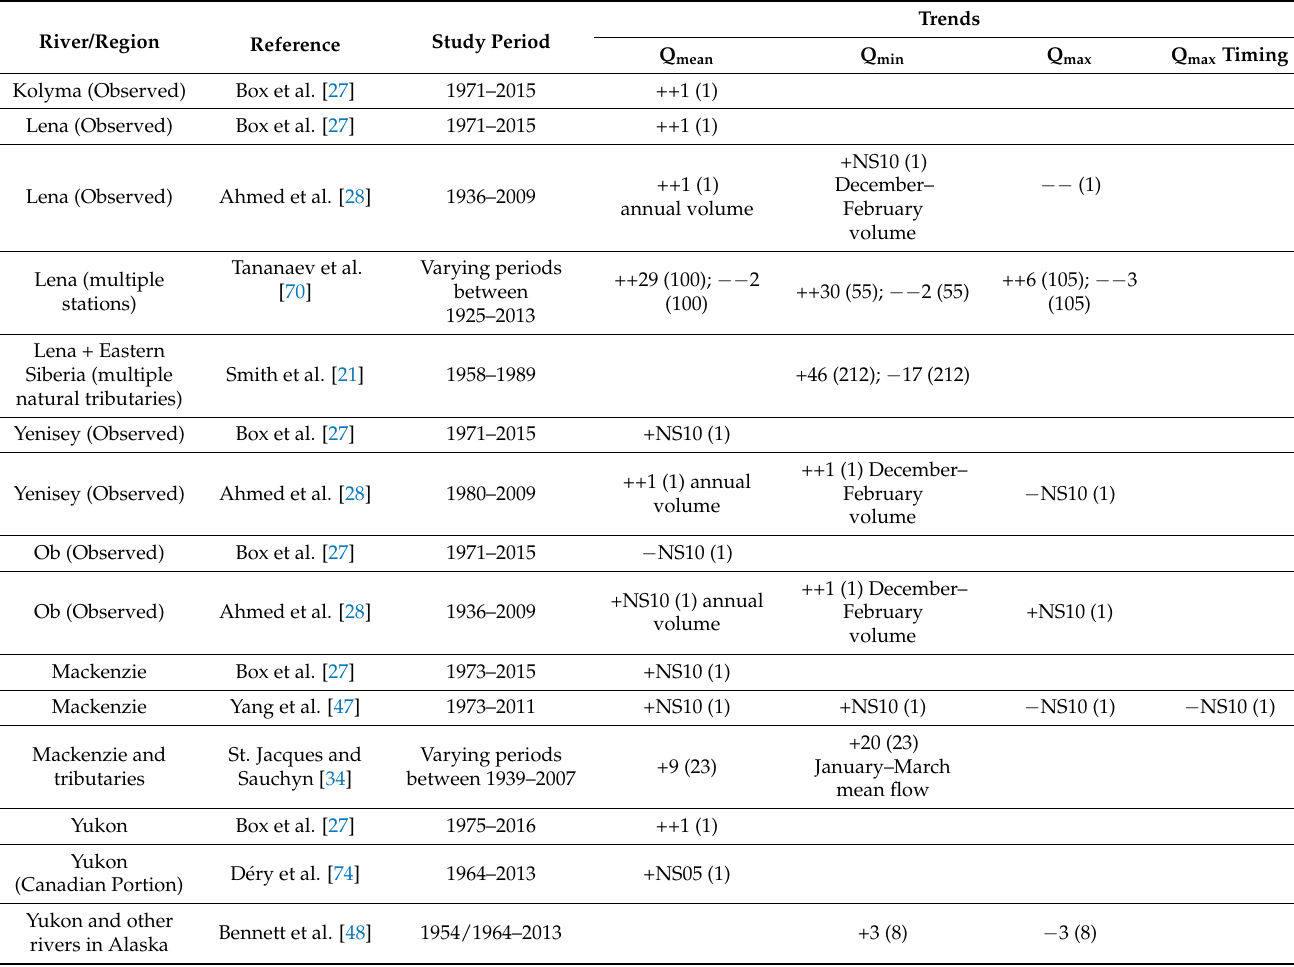
Table A1. Summary of previous studies on streamflow trends for major pan-Arctic